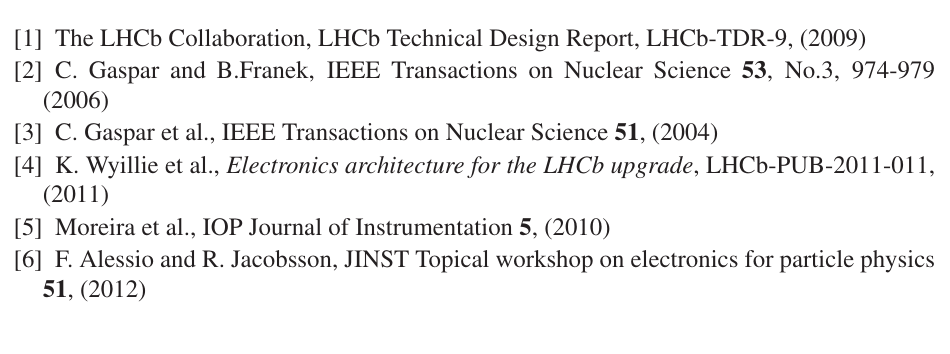
Figure 4. MiniDAQ Run Control FSM Hierarchy.